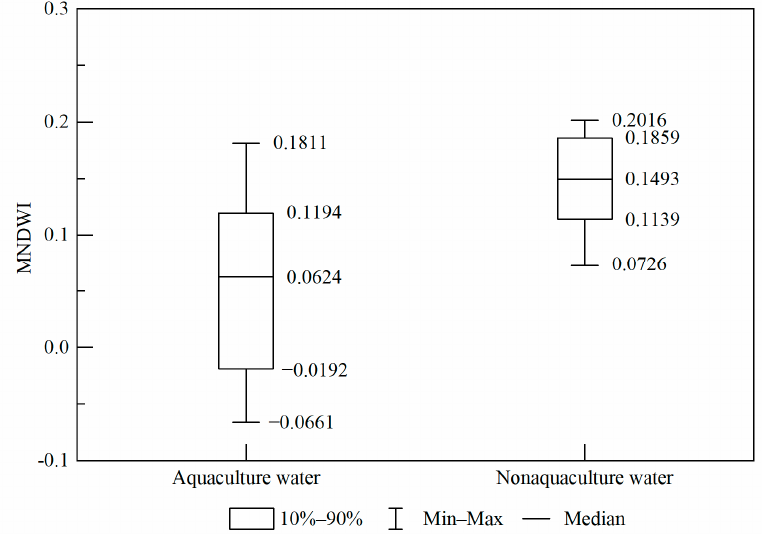
Figure 7. Comparison of MNDWI values between aquaculture and non-aquaculture water bodies in the study area.